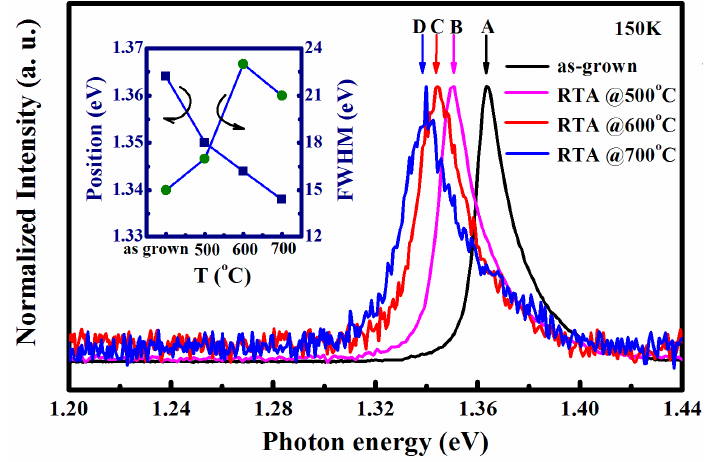
Figure 9. Effects of rapid thermal annealing (RTA) temperature on the emission properties of GaAs x Sb 1 − x . Reproduced with permission from Gao et al., Optical Materials Express; published by the Optical Society of America, 2017 [50].